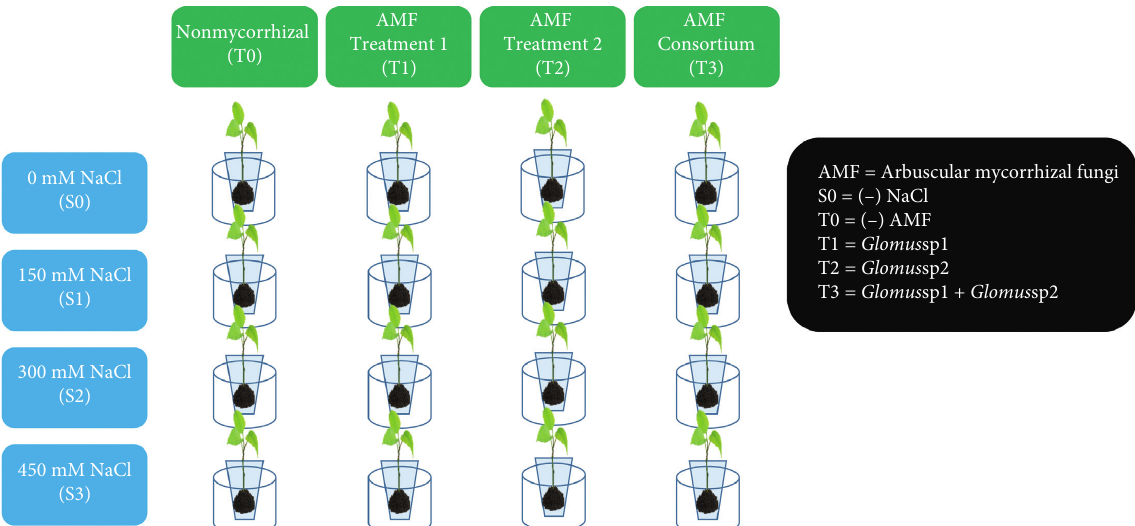
Figure 1: Experimental layout (4 × 4 factorial) for the greenhouse experiment, including salinity and AMF treatments. Each treatment had 5